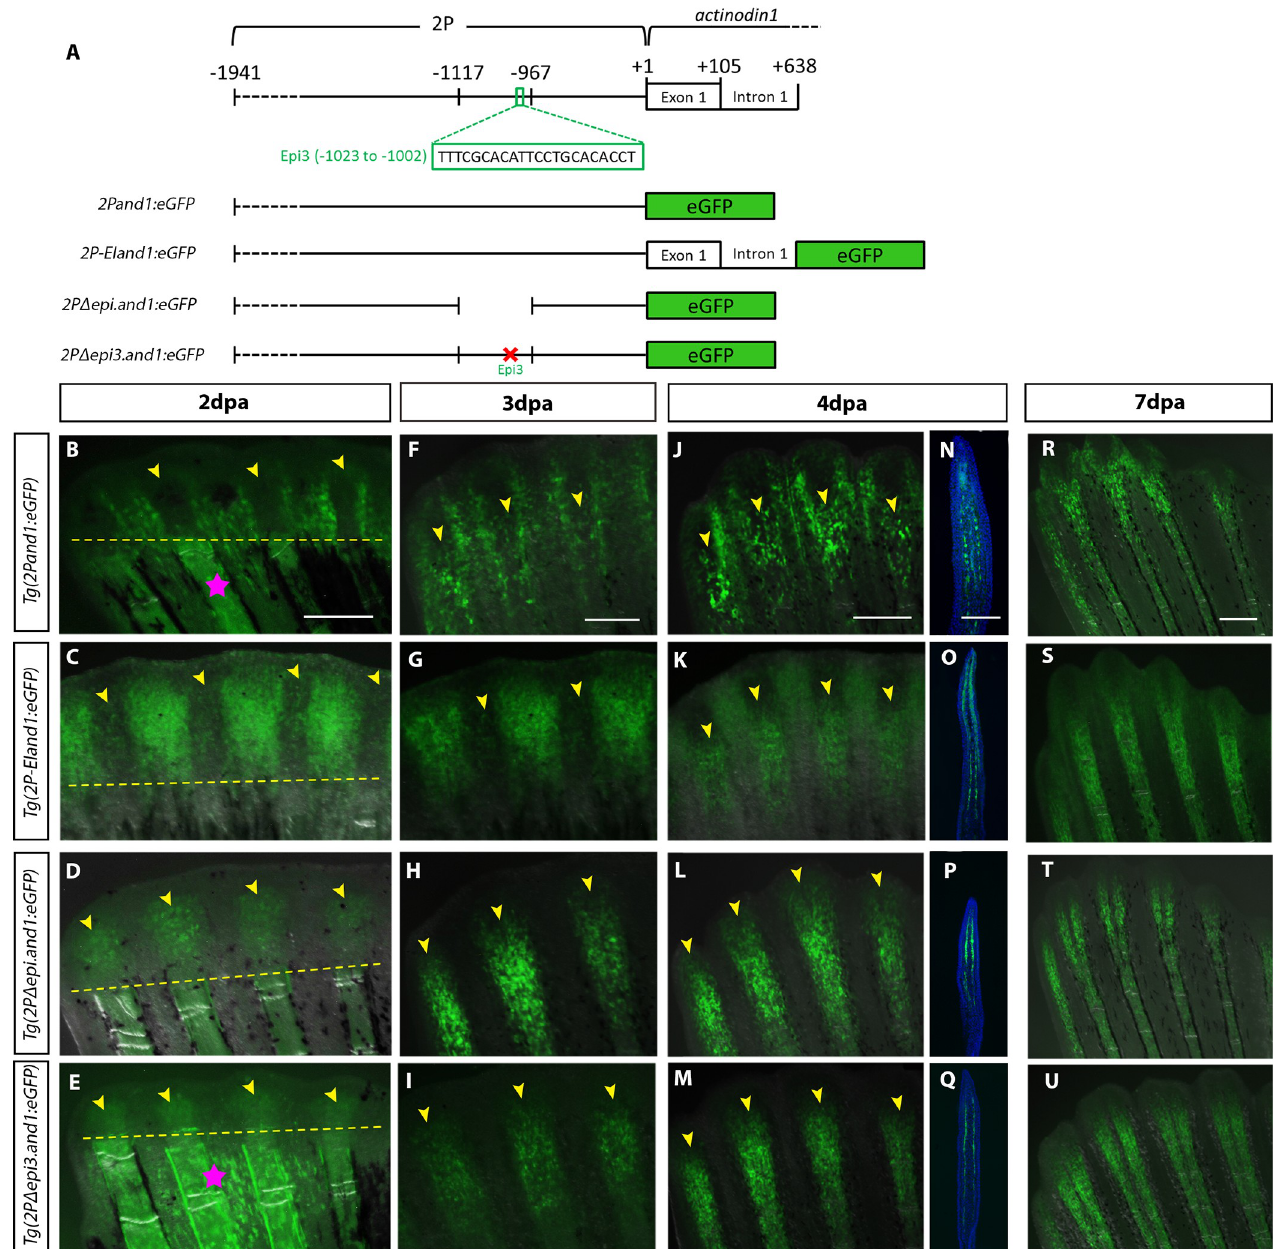
Fig 4. The epi3 site within the epi region contains a mesenchymal-specific repressor that is active early in regeneration. (A) Schematic representation of constructs. In vivo time course analysis of reporter expression in Tg(2Pand1 : eGFP) (n = 7) (B, F, J, R), Tg(2P-EIand1 : eGFP) (n = 12) (C, G, K, S), Tg(2P Δ epi . and1 : eGFP) (n = 11) (D, H, L, T), and Tg(2P Δ epi3 . and1 : eGFP) (n = 13) (E, I, M, U) during fin regeneration. Fluorescent images are merged with bright field images. (N-Q) Immunostaining for eGFP on longitudinal cryosections of 4dpa fin regenerates. (B-E) At 2dpa, Tg(2Pand1 : eGFP) and Tg(2P-EIand1 : eGFP) only have interray epithelial-specific expression while Tg(2P Δ epi . and1 : eGFP) ,and Tg(2P Δ epi3 . and1 : eGFP) have fin ray mesenchymal-specific expression. (F, G) At 3dpa, Tg(2Pand1 : eGFP) and Tg(2P-EIand1 : eGFP) have bright interray epithelial-specific expression and faint fin ray mesenchymal-specific expression. (H, I, L, M) In Tg(2P Δ epi . and1 : eGFP) and Tg(2P Δ epi3 . and1 : eGFP) ,strong fin ray mesenchymal-specific expression is observed. (J, N, R) At 4dpa and 7dpa, fin ray mesenchymal- and basal epithelial-specific expression in Tg(2Pand1 : eGFP) is faint and patchy. (K-M, O-Q, S-U) Reporter expression in Tg(2P-EIand1 : eGFP) is bright in the interray, while fin ray mesenchymal-specific expression is just as bright as that of Tg(2P Δ epi . and1 : eGFP) and Tg(2P Δ epi3 . and1 : eGFP ).Time course analysis was done on one line for each construct; n = # of fish/ line. Pink stars in B and E indicate autofluorescence from white pigment cells and blood vessels. Yellow arrowheads indicate fin ray regenerative tissue. Amputation plane is delineated by yellow dotted line. Scale bars = 200 μ m.